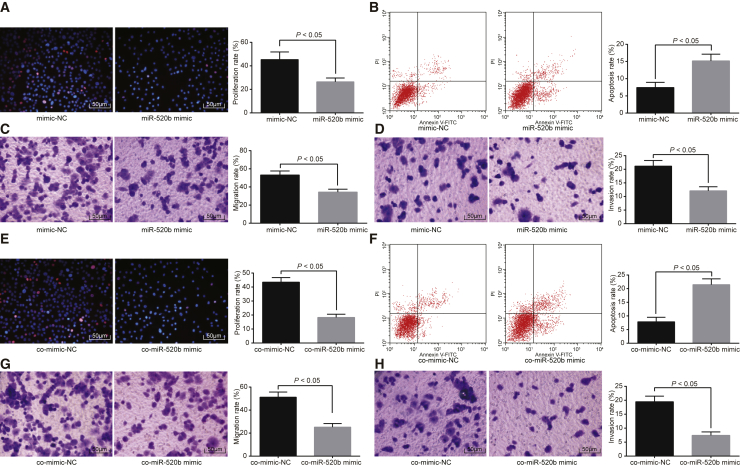
miR-520b Overexpression Inhibits PC Cell Proliferation, Migration, and Invasion yet Promotes Apoptosis(A) miR-520b mimic inhibited SW1990 cell proliferation detected by the EdU assay. (B) miR-520b mimic promoted SW1990 cell apoptosis detected by flow cytometry. (C) miR-520b mimic inhibited SW1990 cell migration by the Transwell assay (×200). (D) miR-520b mimic suppressed SW1990 cell line invasion by the Transwell assay (×200). (E) miR-520b mimic in the NFs inhibited the proliferation of PC cells detected by the EdU assay. (F) miR-520b mimic in the NFs promoted PC cell apoptosis detected by flow cytometry. (G) miR-520b mimic in the NFs suppressed the migration of PC cells detected by the Transwell assay (×200). (H) miR-520b mimic in NFs disrupted the invasion of PC cells detected by the Transwell assay (×200). Data in the figure were presented as mean ± standard deviation, and the difference of which between two groups was compared by independent-sample t test. The experiment was repeated 3 times independently.